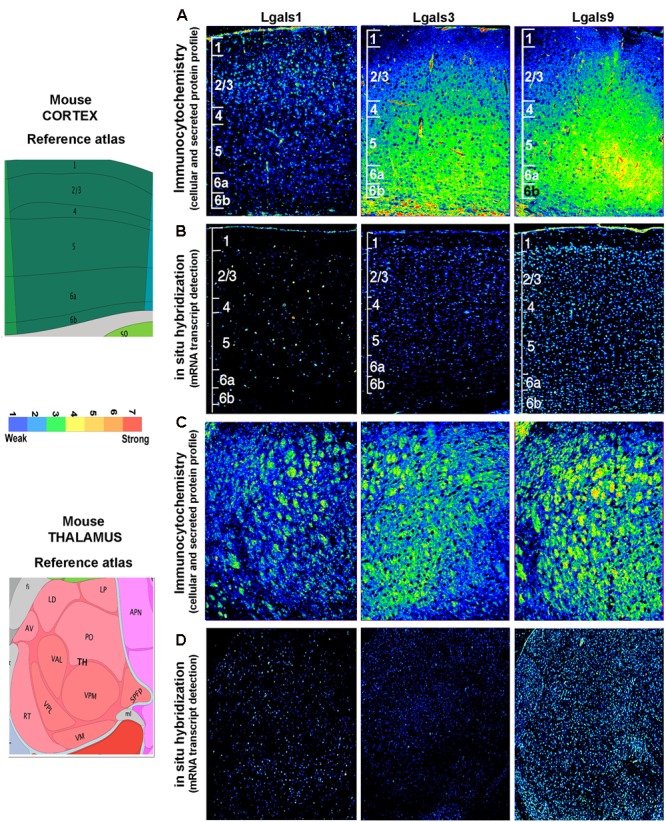
Comparison and validation of galectins’ mRNA expression with protein profiling in mouse Cerebral cortex and Thalamus. (B,D) ABA based mRNA expression profile of 3 major galectins in cortex and thalamus was compared with immunohistochemistry based protein expression in the respective regions as shown in (A,C). The individual cortical layer are marked from L1 to L6b and pseudo-color calibration bar is included to represent the intensity of expression. Note a good regional corroboration between mRNA and protein expression except that the protein expression is more widespread due to the secretory nature. The protein is also detected in the extracellular space which is suggestive of autocrine-paracrine effects.